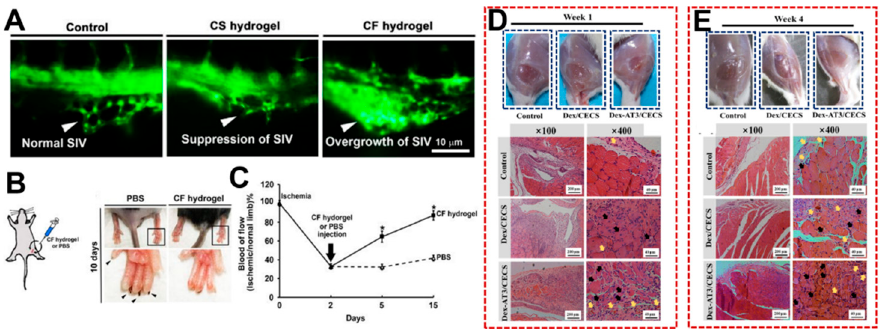
Figure 9. ( A ) The pattern of the sub intestinal vessels (SIV) in zebrafish embryos in which all of the vascular endothelial cells expressed enhanced green fluorescent protein. Each embryo was injected with PBS, CS hydrogel or CF hydrogel without cells 24 h after fertilization, and the fluorescence microscopic images were taken one day after the injection. ( B ) Representative images of the ischemic hind limbs of mice injected with PBS or CF hydrogel (the animal experiments were performed in accordance with protocols approved by the University Animal Care and Use Committee). The PBS group suffered severe nail loss. No intramedullary nail fell off in the CF hydrogel group and limb salvage was successful. ( C ) The blood flow ratios of ischemic limbs and healthy limbs in different groups showed a significant increase in blood flow after surgery in the hydrogel injection group. Reprinted with permission [32]. © 2017, Nature Publishing Group (London, UK). The regeneration of skeletal muscle tissue was evaluated using H&E staining in a rat skeletal muscle volume loss model after volumetric muscle loss injury and treatment for 1 week ( D ) and 4 weeks ( E ) between three groups, including PBS control, Dex / CECS hydrogel treatment, and Dex-AT / CECS hydrogel treatment (black arrows: centronucleated myofibers; yellow arrows: newly formed blood vessels). Reprinted with permission [91]. © 2019, Elsevier Ltd. (Amsterdam, The Netherlands).